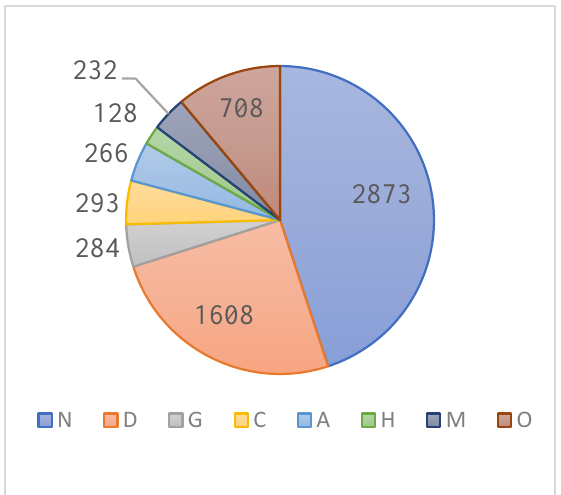
Figure 4. Distribution of ODIR dataset. Normal (N), diabetes (D), glaucoma (G), cataract (C), age-related macular degeneration (A), hypertension (H), pathological myopia (M), other diseases/abnormalities (O).